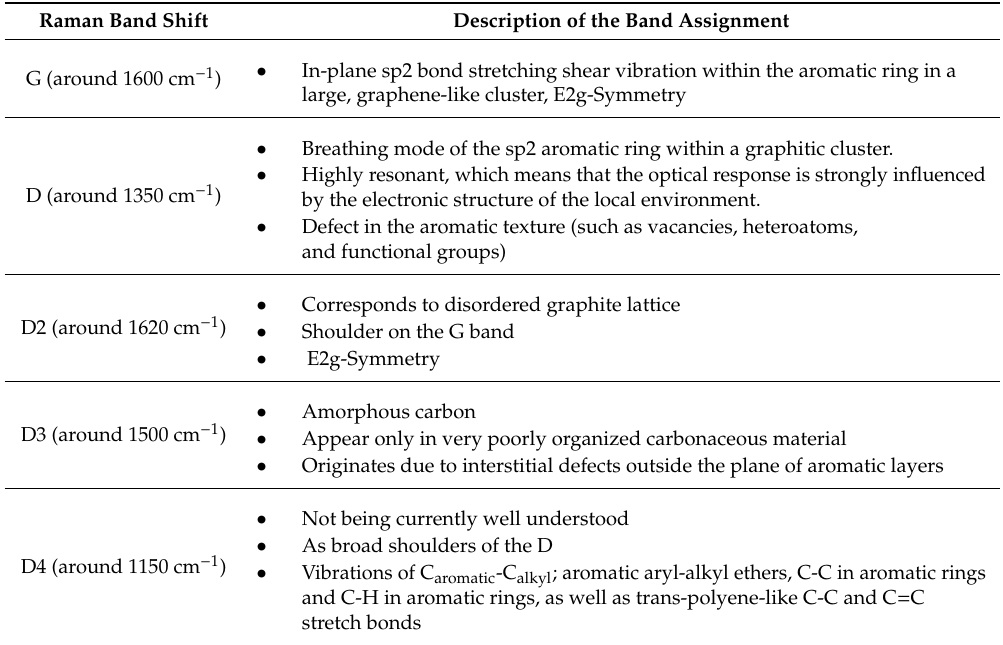
Table 2. Band assignments for Raman peaks